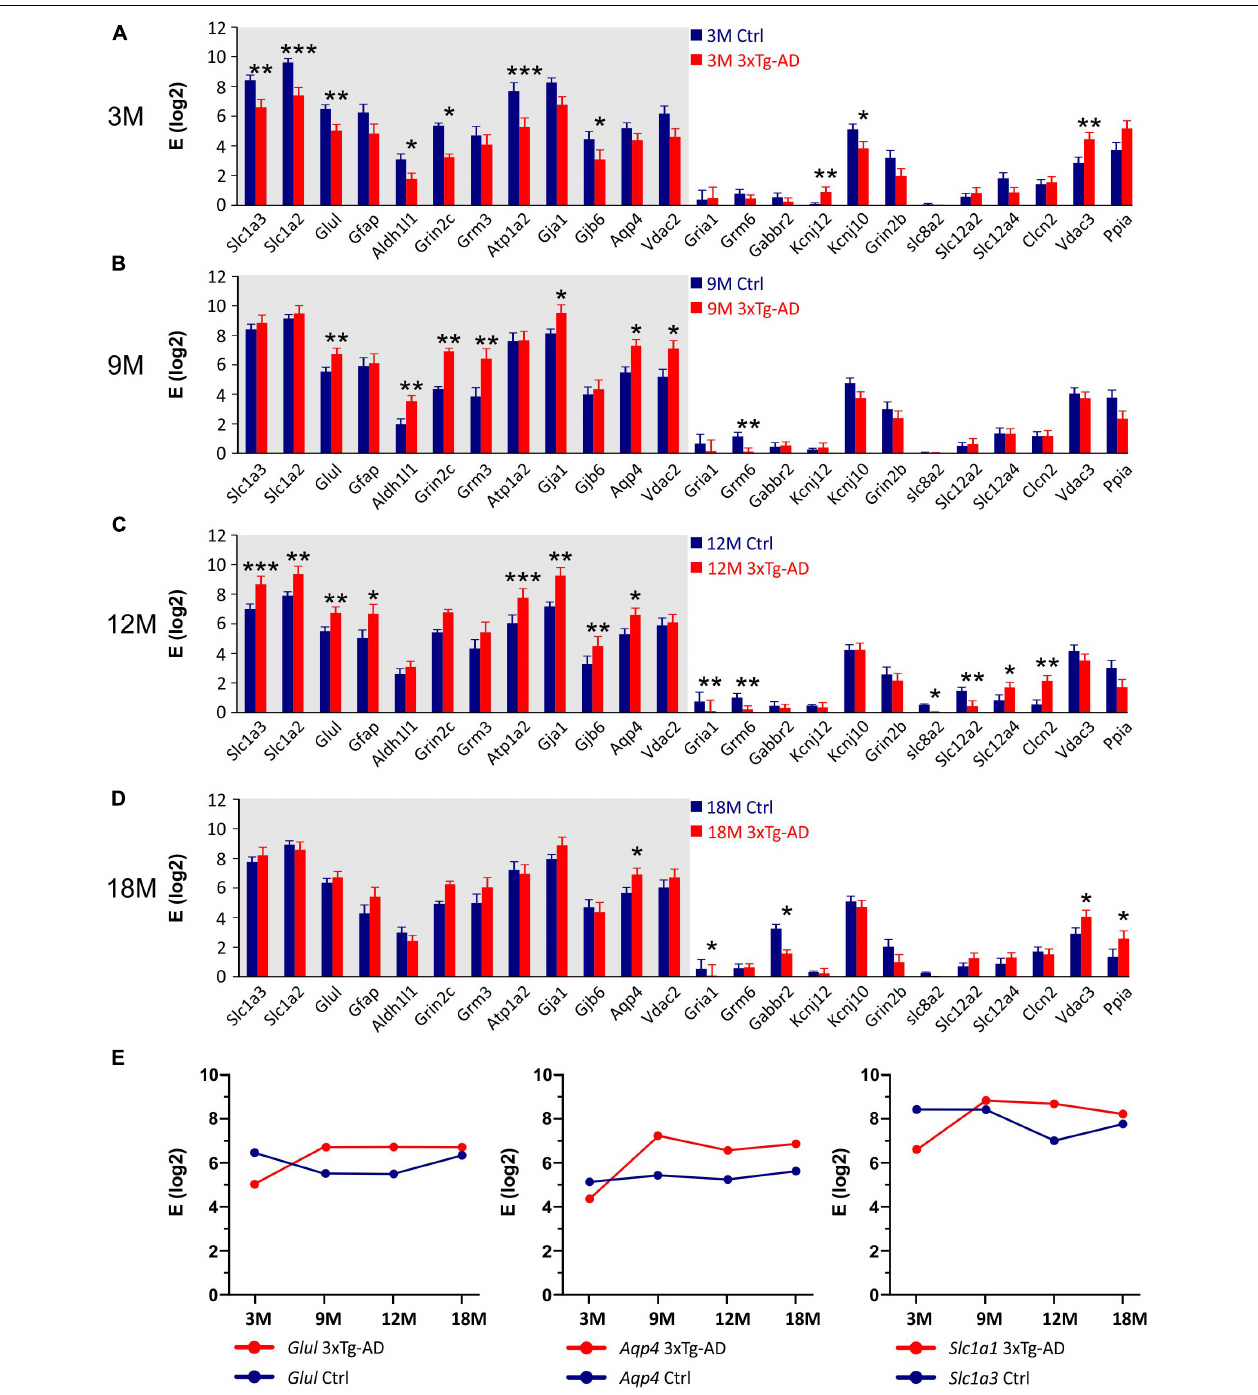
FIGURE 10 | Gene expression analysis in hippocampal EGFP-positive astrocytes of 3xTg-AD mice. (A–D) Relative mRNA levels (log scale) of genes significantly changed in 3M- (A) , 9M- (B) , 12M- (C) and 18M- (D) -old 3xTg-AD mice compared to age-matched controls. Normalized data are expressed as fold changes compared to the sample with the lowest expression of the gene. Data are presented as mean ± SEM. Statistical significance was determined by two-way ANOVA test with Tukey’s post hoc test. Genes undergoing significant changes during aging are indicated by a gray background. Asterisks indicate significant differences (* p < 0.05, ** p < 0.01, *** p < 0.001). (E) Age dependent changes of relative mRNA levels of genes encoding glutamin synthetase ( Glul ), aquaporine 4 ( Aqp4 ) and glutamate transporters GLAST ( Slc1a3 ). Ctrl, control; 3xTg-AD, triple transgenic model of AD crossbred with GFAP/EGFP mice; GFAP, glial fibrillary acidic protein; EGFP, enhanced green fluorescent protein; 3M, 9M, 12M, 18M, 3-, 9-, 12-, 18-month-old animals; Aliases of all genes are summarized in Supplementary Table 1 .